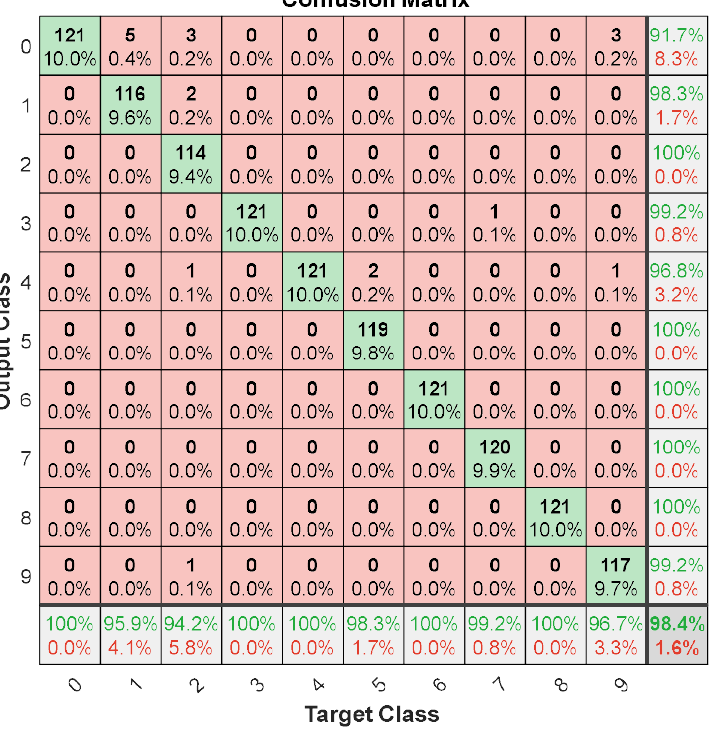
Figure 19. Accuracy and loss rate of SE for noisy LFM by CNN.